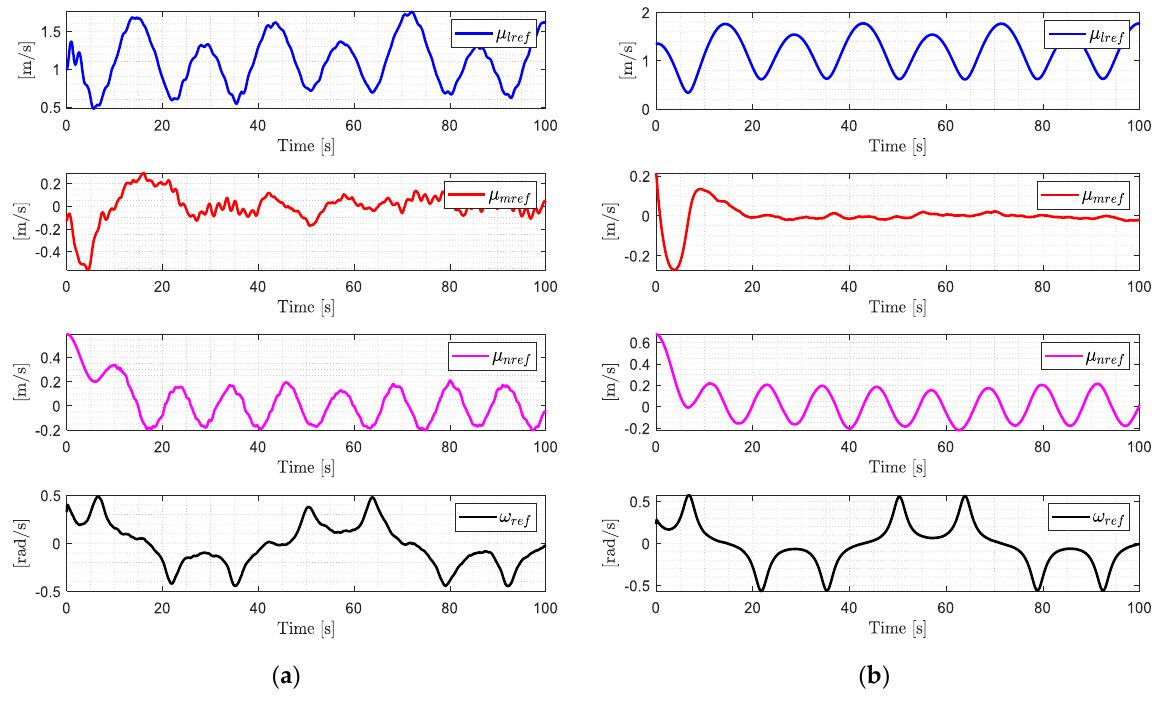
(cid:16) (cid:17) = u ,u ,u , ω μ . ( a ) Real input velocities; ( b ) u lref , u mref , u nref , ω ref . ( a ) Real input velocities; lref mref nref ref ref